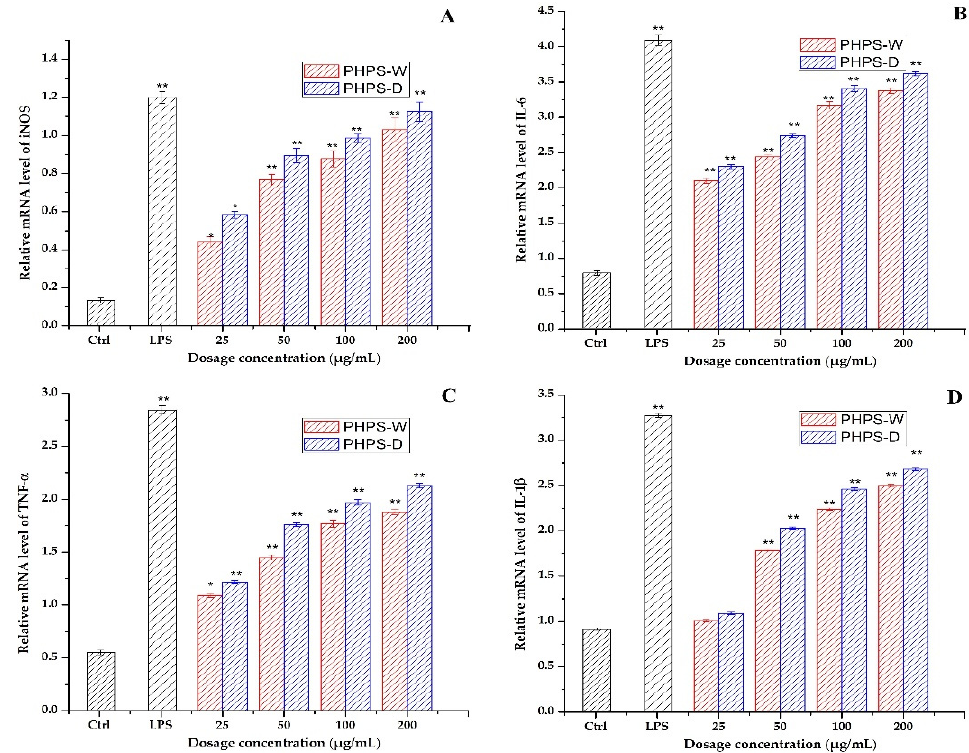
Figure 11. Effect of PHPS-D and PHPS-W treatments on RAW264.7 cells mRNA expression levels of NO ( A ), IL-6 ( B ), TNF- α ( C ), and IL-1 β ( D ). Note: Each experiment was tested in triplicate, and the error bars are standard deviations, Significant differences in the relative mRNA levels in the samples vs. the control group are represented by * p < 0.05 and ** p < 0.01.